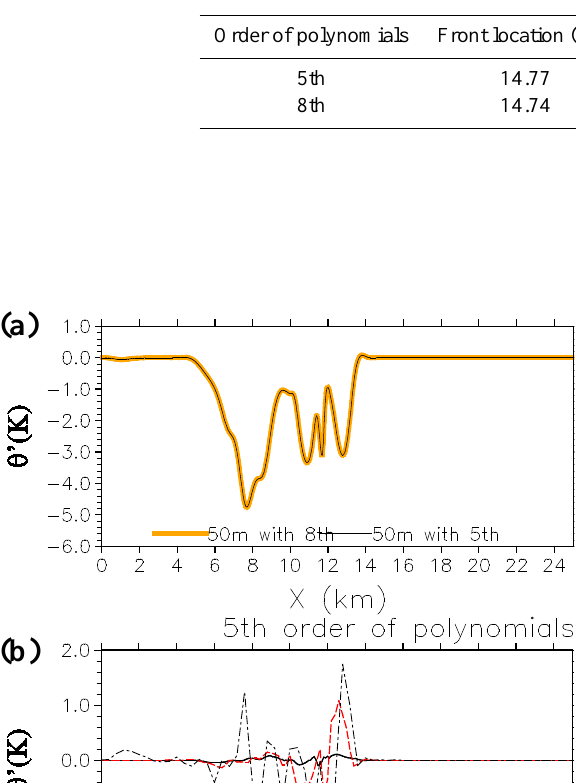
Table 3. Comparison between fifth- and eighth-order polynomials per element for the density current. The simulation was conducted with a resolution of (cid:49) ¯ x = 50m and (cid:49) ¯ z = 50m.